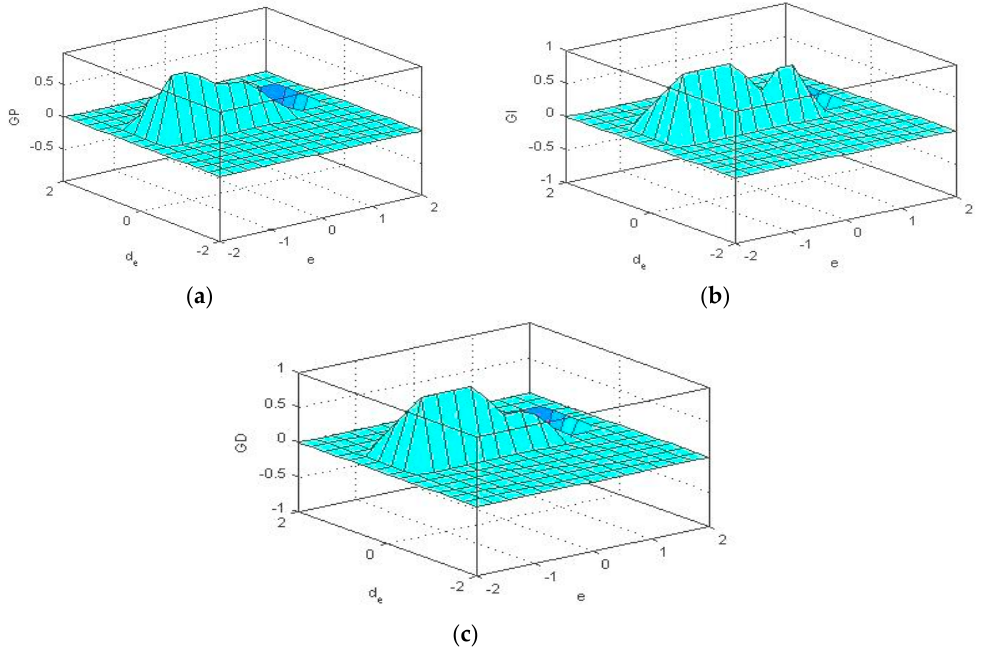
Figure 6. ( a ) The output surface of the fuzzy-based proportional controller; ( b ) the output surface of the fuzzy-based derivative controller; ( c ) the output surface of the fuzzy-based integral controller.